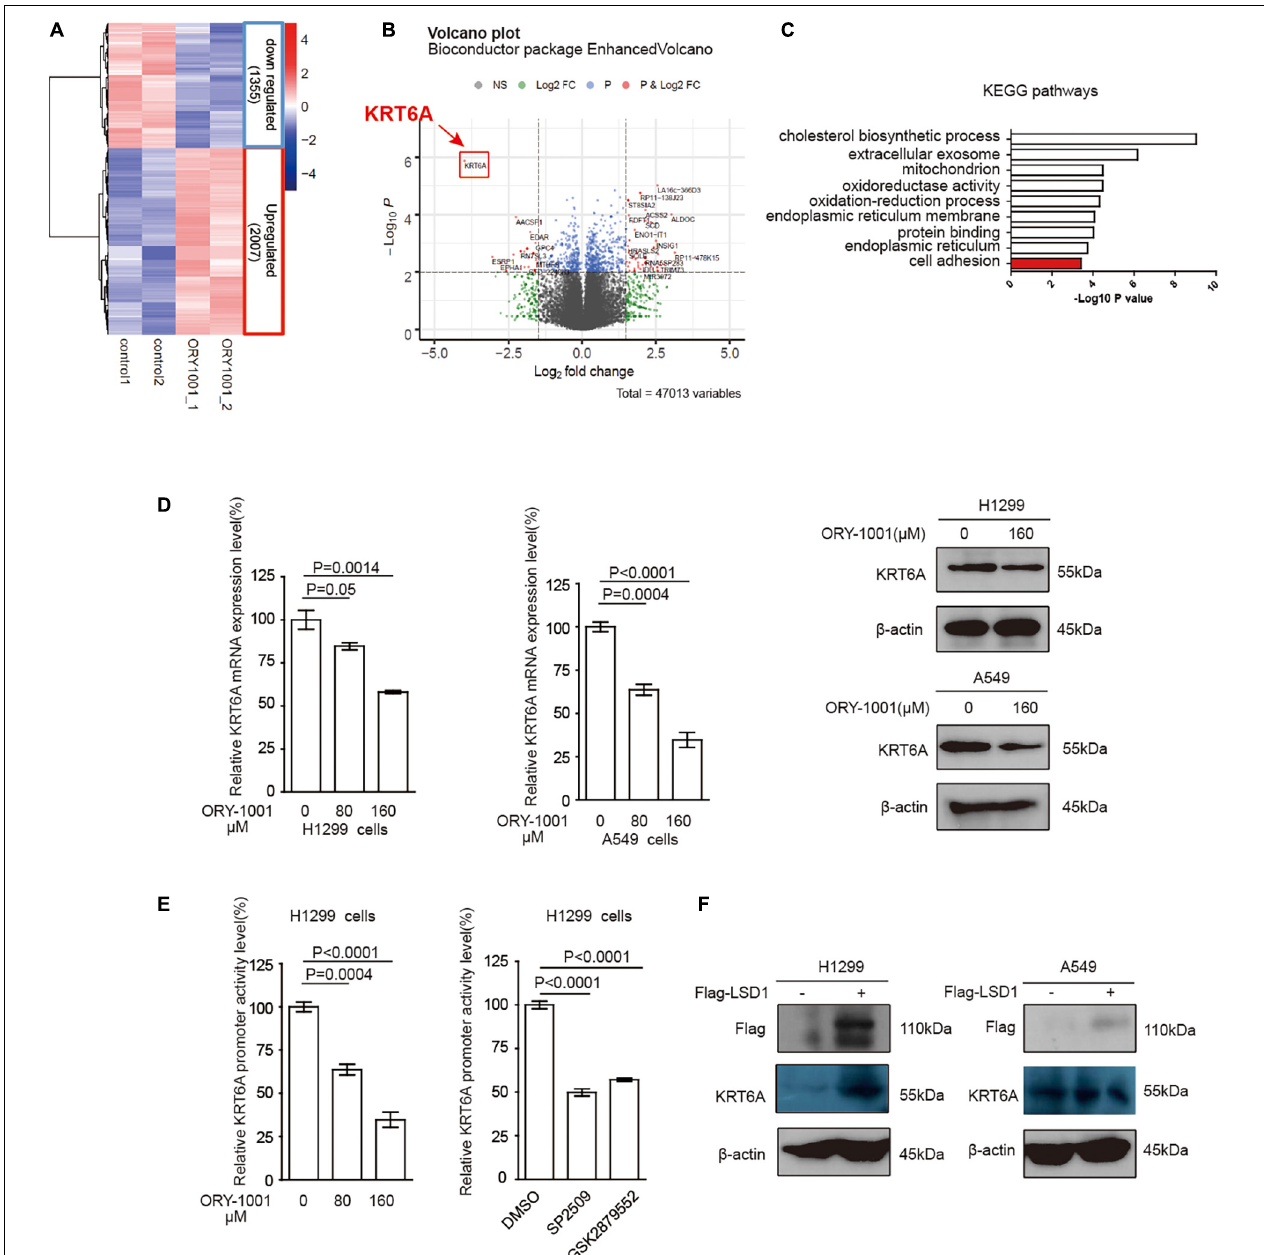
FIGURE 3 | LSD1 is involved in regulating KRT6A expression. (A,B) The transcripts in H1299 cells was determined by RNA-sequencing, showing that KRT6A was significantly reduced in H1299 cells treated with a LSD1 inhibitor ORY-1001. (C) KEGG pathways analysis of the RNA sequencing results revealed that 10 significantly altered pathways were identified and the cell adhesion pathway was highlighted in red. (D) The mRNA and protein expression of KRT6A after ORY-1001 treatments were significantly lower compared to control in H1299 and A549 cells. (E) The LSD1 inhibitors (ORY-1001, SP2509, and GSK2879552) led to significantly reduced KRT6A promoter activity. (F) Overexpression of LSD1 promotes KRT6A protein